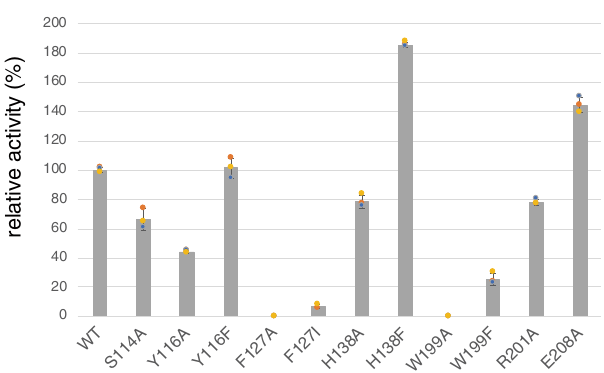
Fig. 6 Graph representing the relative activities of the NvfI variants. The bars are means of n = 3 independent experiments and error bars indicate standard deviations. Data are presented as mean values ± SD. All experiments were repeated independently three times with similar results. The relative activities were calculated from the total turnover